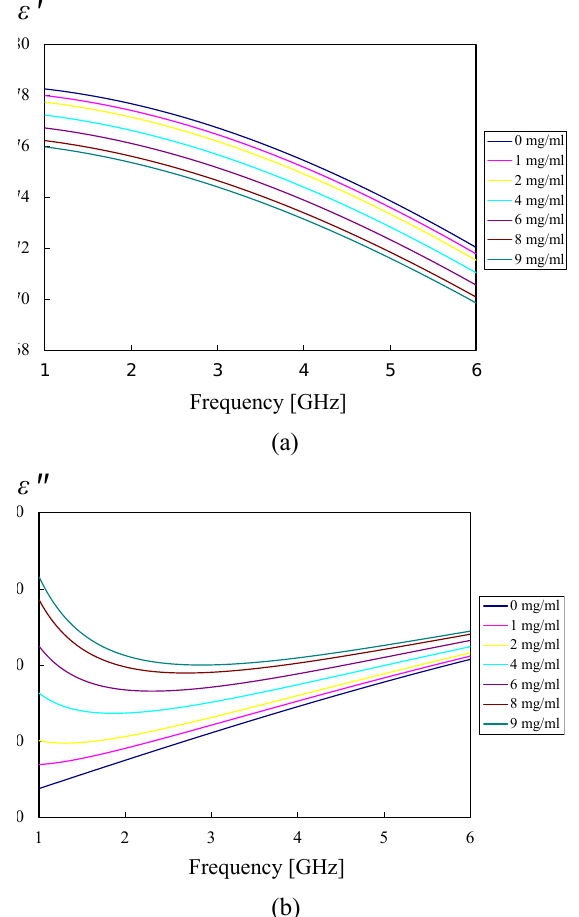
Figure 3: Frequency dependence of the complex permittivity for different NaCl solutions. (a) Real part of ε as a function of frequency. (b) Imaginary part of ε as a function of frequency.